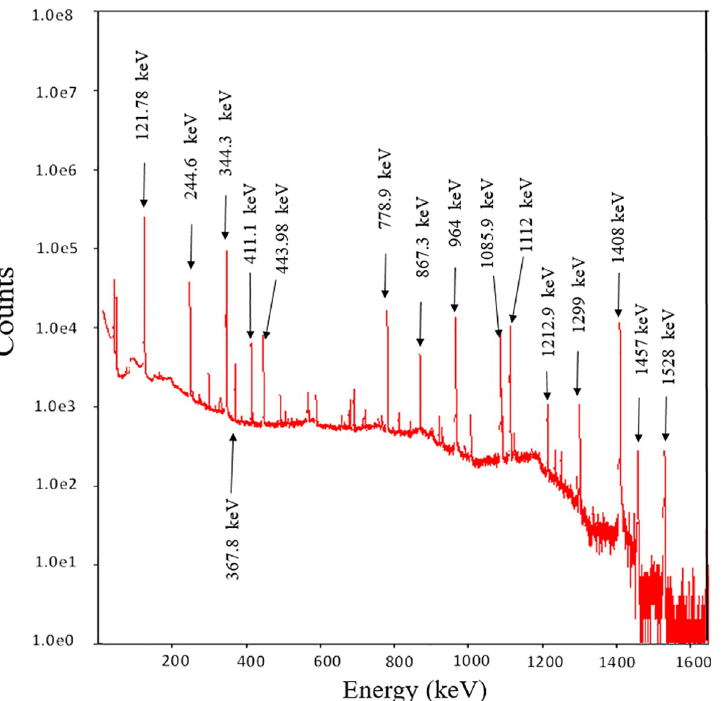
The counting efficiencies of the 238 U series for these measurement conditions was 1.1% for 214 Pb (351.8 keV) and 0.64% for 214 Bi (609.3 keV), while for the 232 Th series, they were 1.52% for 212 Pb (238.4 keV), 1.24% for 228 Ac (338.2 keV), 0.6% for 212 Bi (727 keV), 0.71% for (583 keV), 0.16% for 208 Tl (2614 keV), and 0.2% for 40 K (1460 keV). With the exception of 40 K, all gamma lines have a high branching ratio [11]. The efficiency curve (Fig 3) covers the photon energy range 121.78–1528 keV with a fitting polynomial of order 4, as given by Alnour et al.